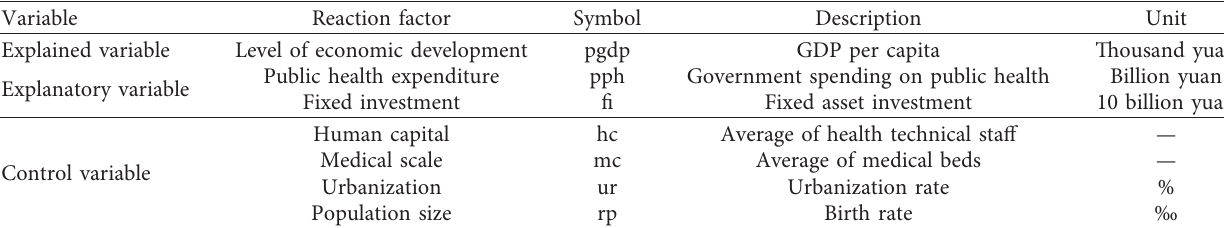
Table 1: Variable descriptions.